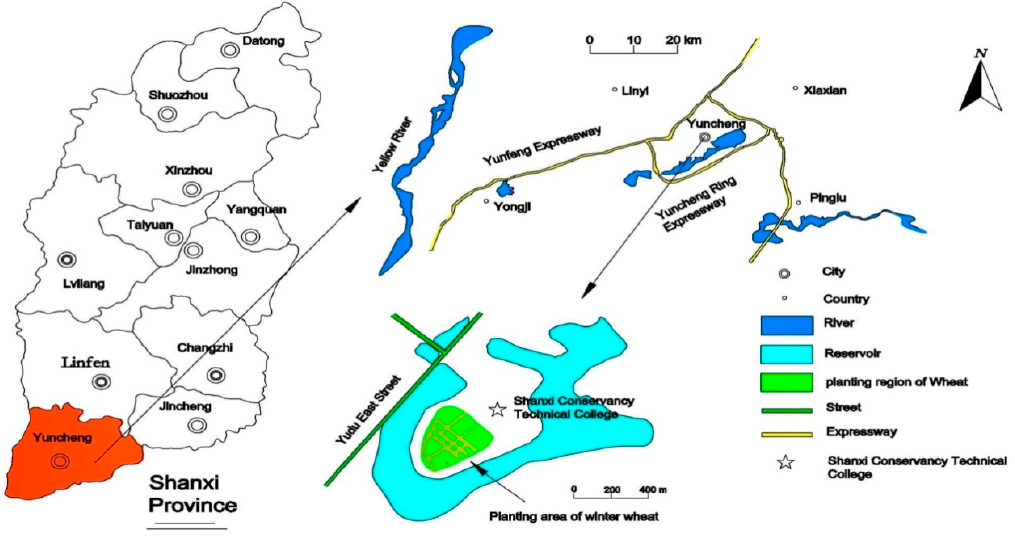
Figure 1. Location of study sites. Table 1. Texture composition of the soil.